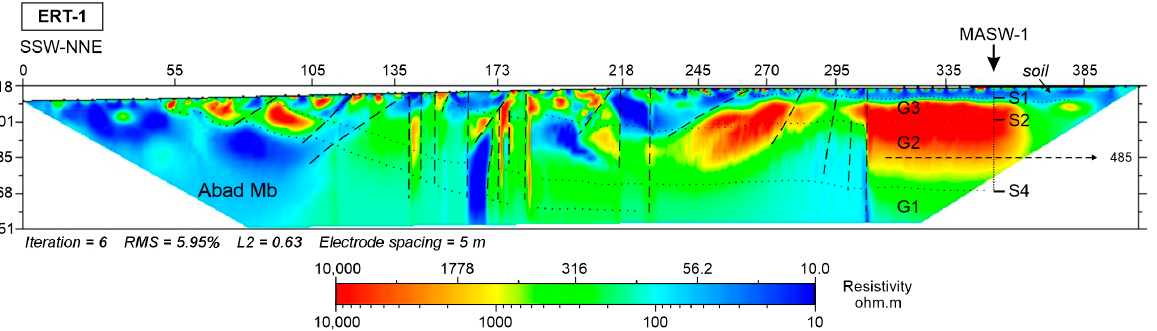
Figure 10. Inverted electrical resistivity tomography data of the southernmost area (S edge) affected by numerous faults and fractures. The seismic survey point (MASW-1) is indicated.